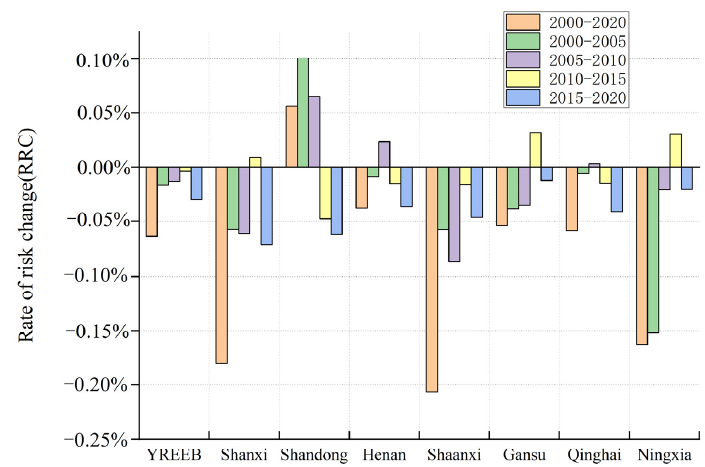
Figure 7. The rate of risk change for the YREEB and provinces in different periods. Changes in ecological risk were unevenly distributed. From 2000–2020, most regions reduce risk at a rate of 0–0.05% per year (Figure 8). The rest of the units with slightly increased risks were mainly concentrated in the south and north of Qinghai, and the north of Gansu (Figure 8a). During 2000–2005, the risk reduction units were mainly distributed in the central region, mainly in most regions of Shanxi, Ningxia, and Shaanxi, especially in the northwest of Gansu (Figure 8b). During 2005–2010, the units of increased risk gradually decreased, with uneven and sporadic distribution, mainly scattered in the northern part of Qinghai (Figure 8c). During 2010–2015, the regions where the risk decreased obviously showed a trend of gradual diffusion from the middle to the four sides, and the regions with rapid decline appeared in western Shandong, central Henan, and southern Qinghai (Figure 8d). During 2015–2020, the number of risk growth units increased significantly, and were concentrated in southern Qinghai, southern Shaanxi, and small adjacent areas with increasing risks in Gansu (Figure 8e). In general, the change rate of risk growth units was generally lower than that of risk decline units, so the overall risk in the study area had not increased significantly.